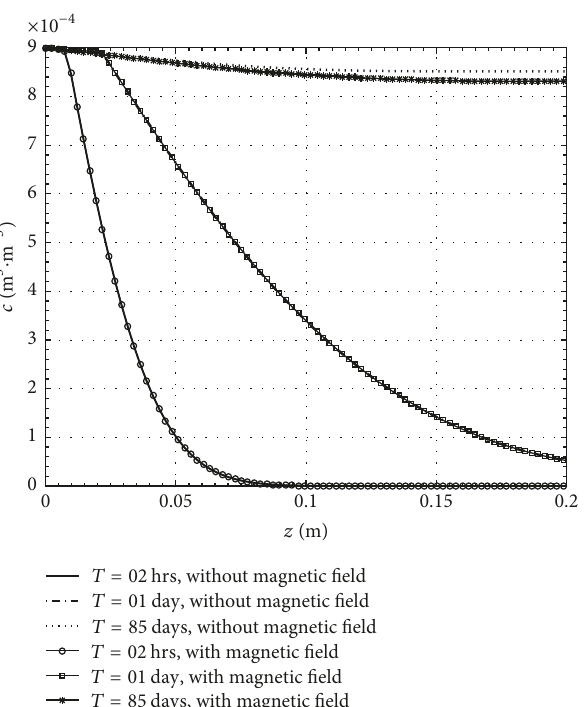
Figure 6: Pore wall deposited nanoparticles concentration against core length with and without magnetic field effect for various values of imbibition time: magnet is placed on the right side of the core.